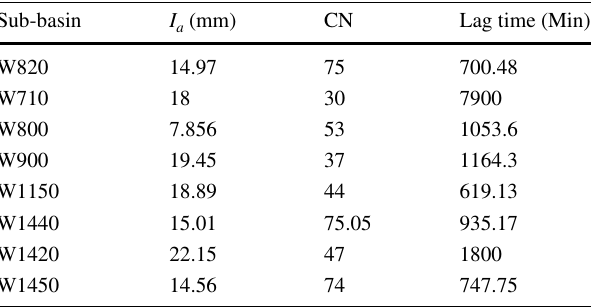
Table 13 Calibrated model parameters SCS CN loss rate method Sub-basin